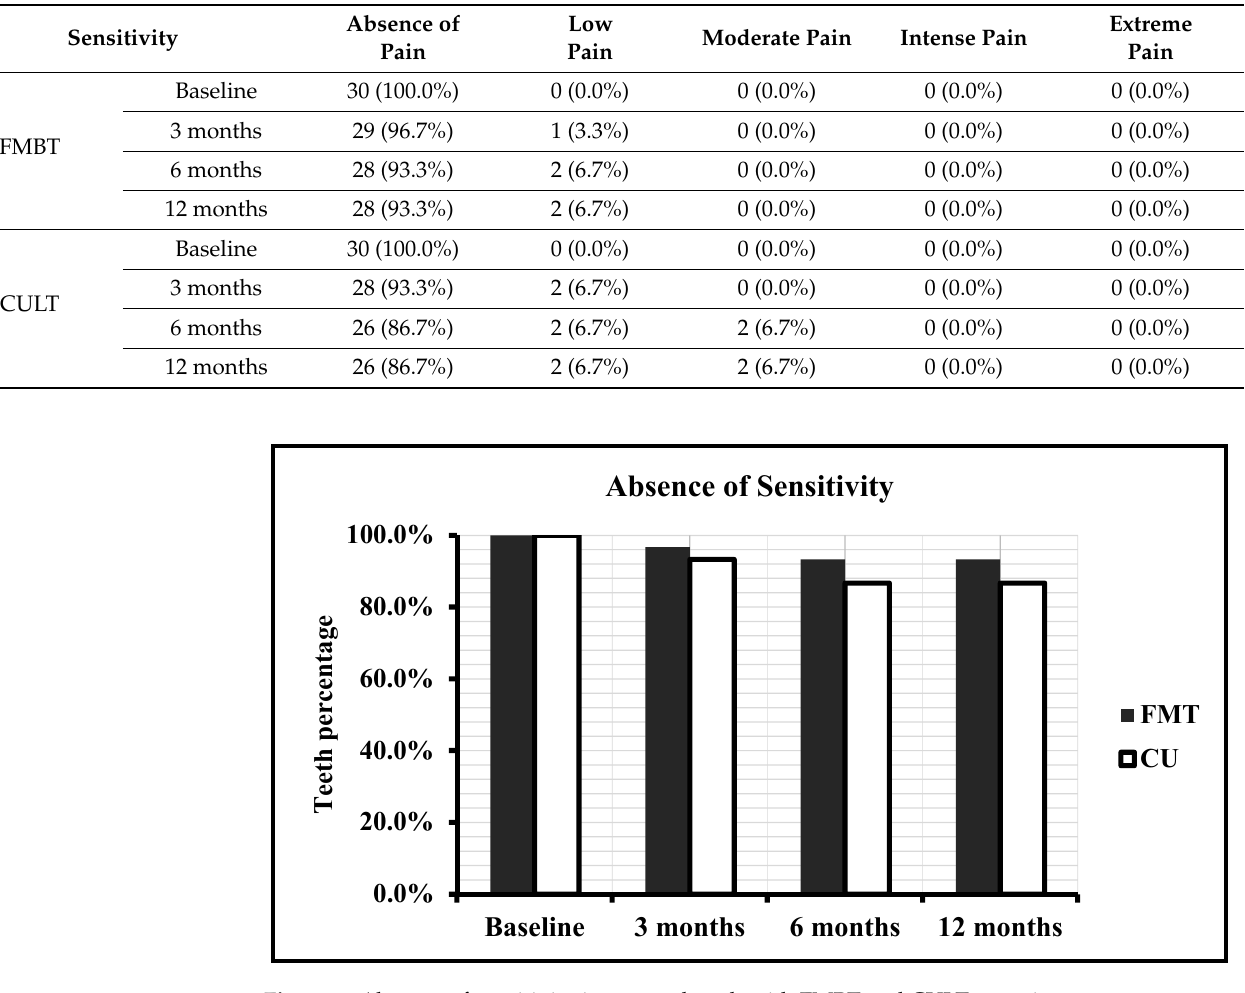
Secondary Caries